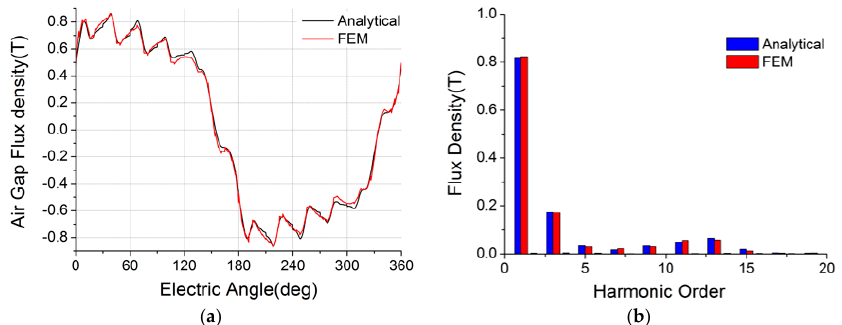
Figure 6. Air-gap flux density in the middle of the slotless air gap caused by permanent magnet, q-axis current and d-axis current respectively.